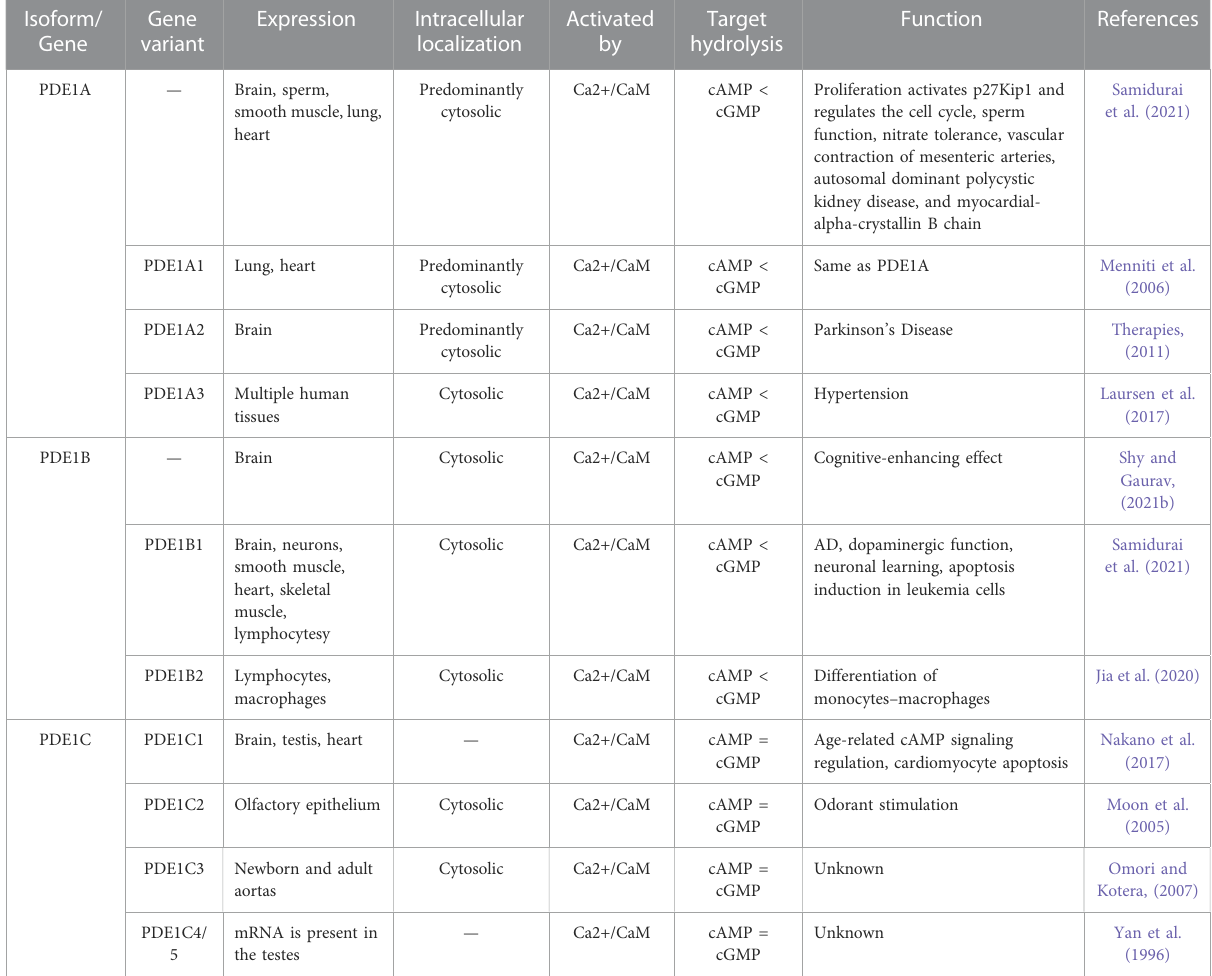
TABLE 1 Expression, localization, and function of PDE1 isoforms and their gene variants. Isoform/